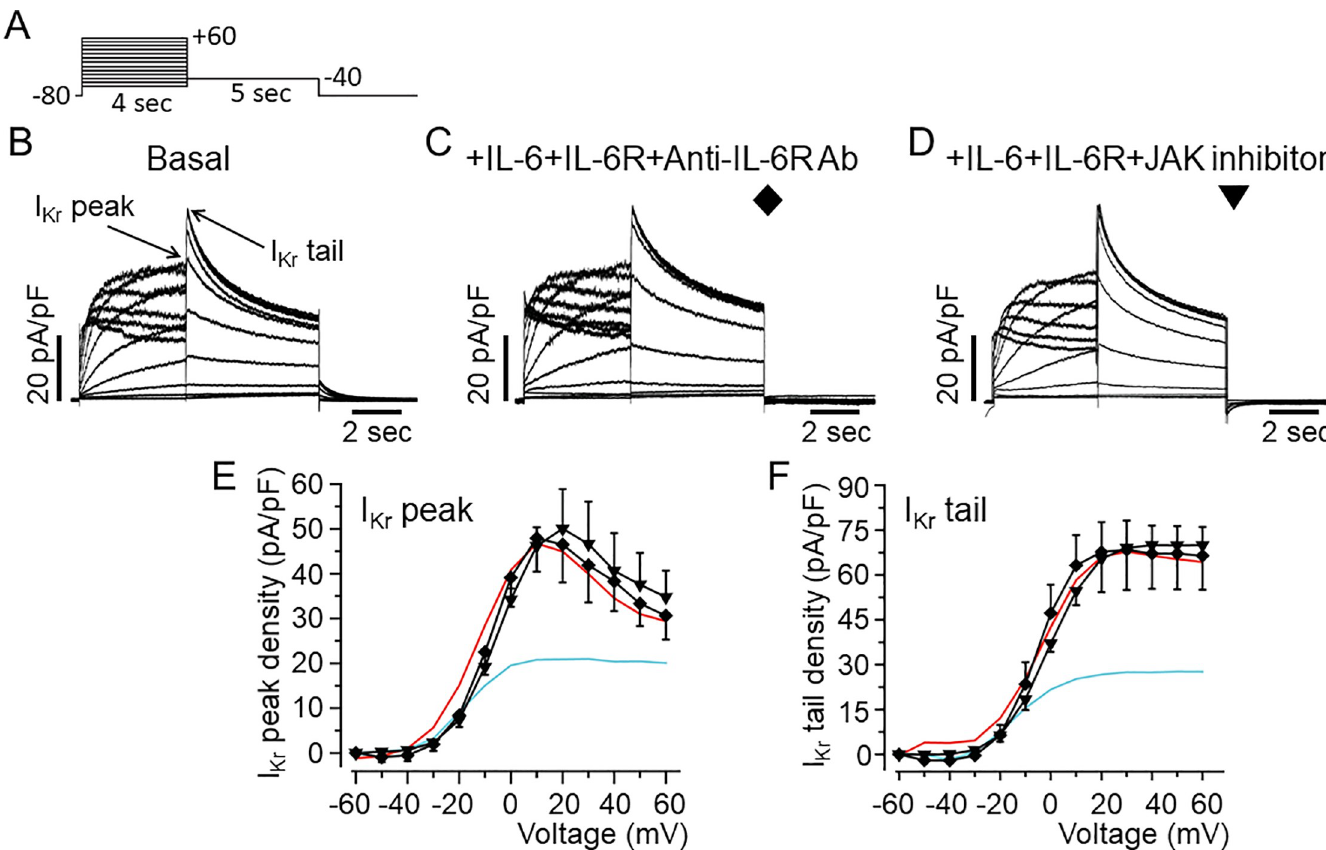
Fig 4. Inhibition of I Kr by IL-6 is prevented by IL-6R and Janus Kinase blockade in HEK293 cells. A , Voltage-clamp protocol used to generate I Kr in HEK-hERG cells stably expressing hERG channel. B , Basal hERG currents. Arrows indicate hERG peak and tail currents. C , Representative I with IL-6+IL-6R in the presence of anti-IL-6R antibody (Ab). D , I Kr currents measured in HEK-hERG cells pre-treated with IL-6+IL-6R and the JAK inhibitor-1. Plots of I peak current density-voltage ( E ) and tail current density-voltage curves ( F ) in the presence of anti-IL-6R antibody (n = 4) and the JAK inhibitor-1 (n = 4). I Kr current and tail density-voltage curves for I Kr measured in basal condition ( Red line ) and in cells pre-treated with IL-6+IL-6R ( Cyan line ) are shown for comparison.